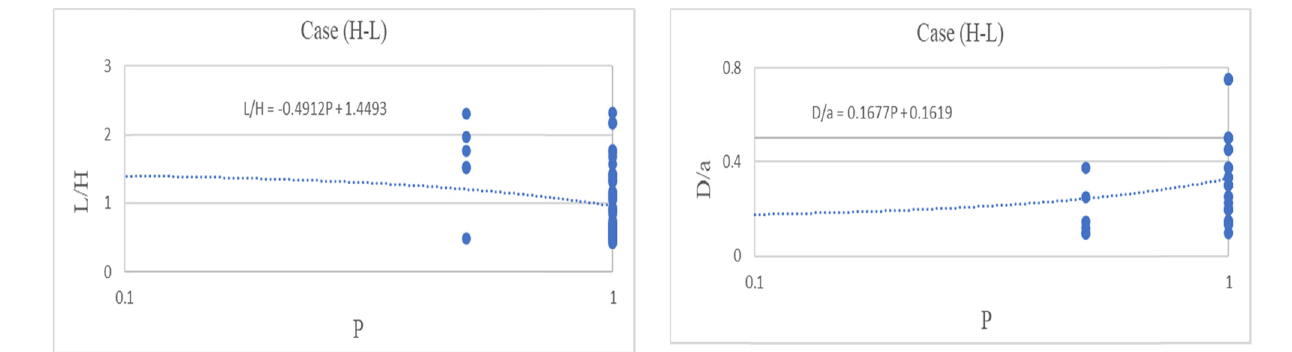
diameter ( L and D ) , respectively, on trap index prob - ability for rootstocks cases ( H – L ) . Figures 11 and 12 represent the e ff ects of the upstream head ( H ) , driftwood length ( L ) , and diameter ( D ) on the trap index ( P ) ; from the fi gures, it can be seen the most critical in fl uence factor is the upstream head compared with other factors, when ( L / H and D / H ) decreasing, respectively, the probability of the trap index increased. These cases can be expressed in equations ( 8 ) and ( 9 ) .